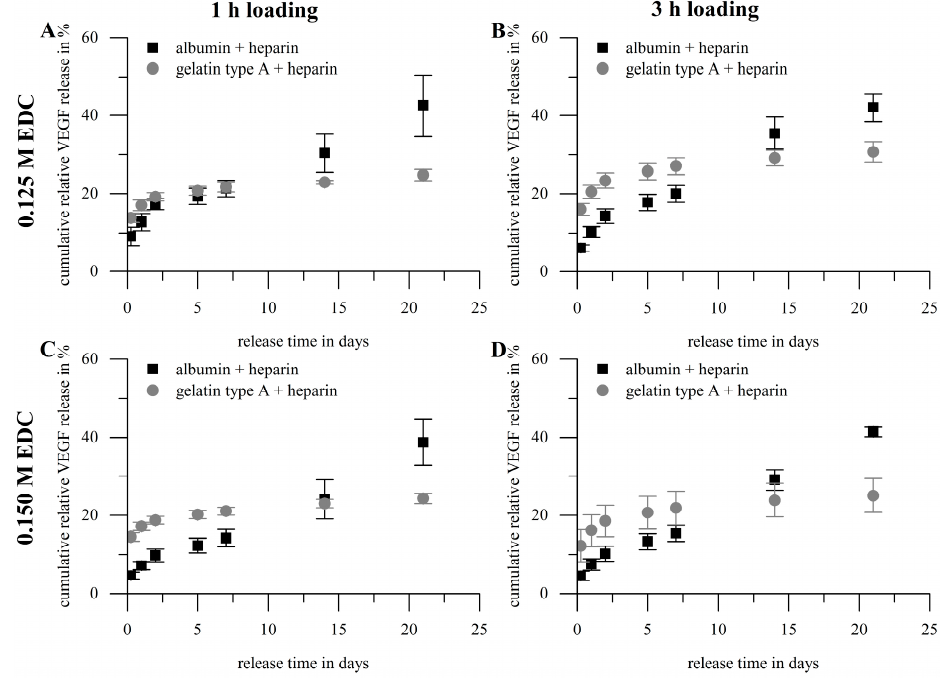
Figure 6. Cumulative release profiles of hydrogels prepared with gelatin type A (10 wt %) or albumin (10 wt %) with heparin (1 wt %). Loading was achieved by swelling in vascular